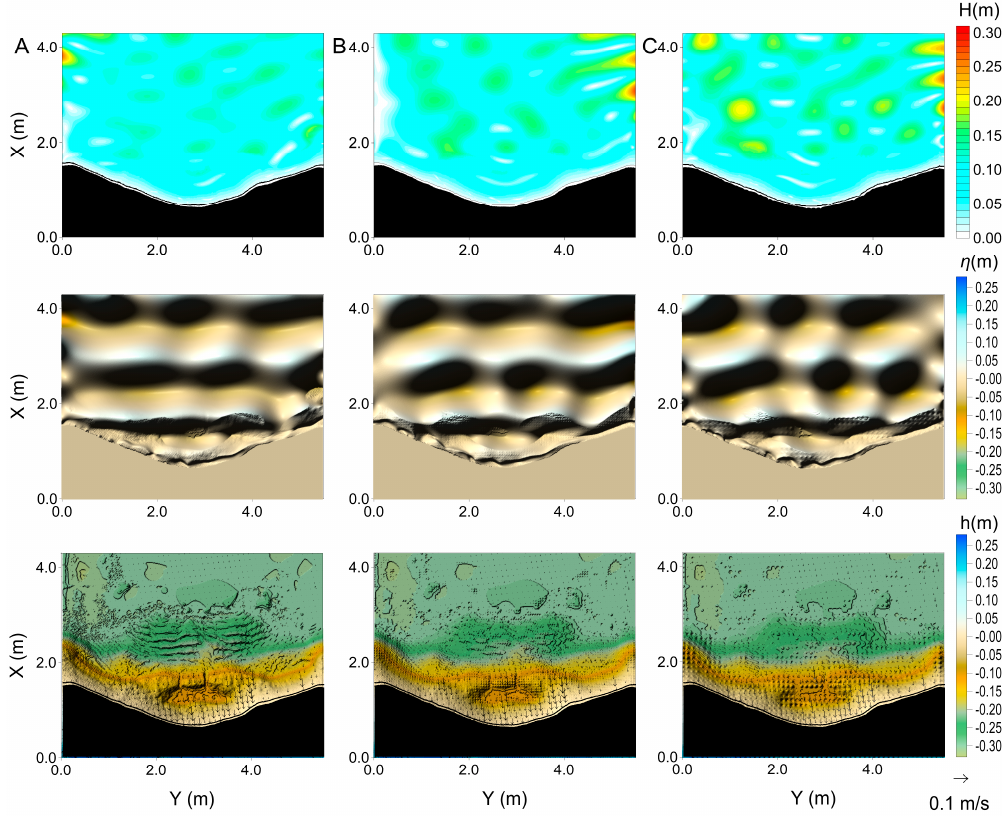
Figure 6. The wave modeling results derived based on 1 cm ( A ), 5 cm ( B ) and 10 cm ( C ) beach models. From top to bottom row are the wave height, instantaneous free surface, and currents, respectively.